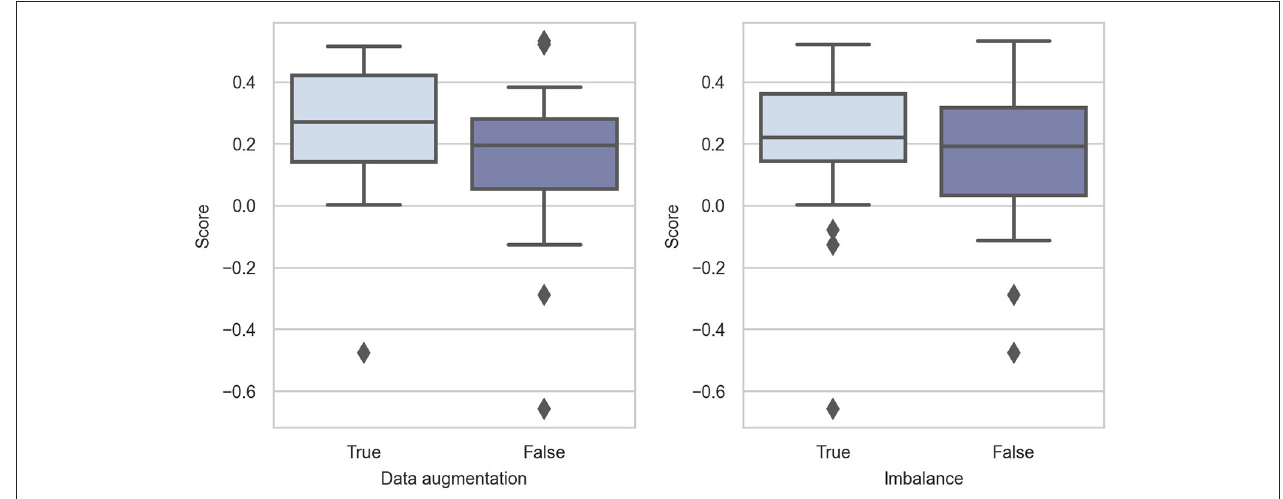
FIGURE 3 | Box-plots of score distributions of data preprocessing techniques.